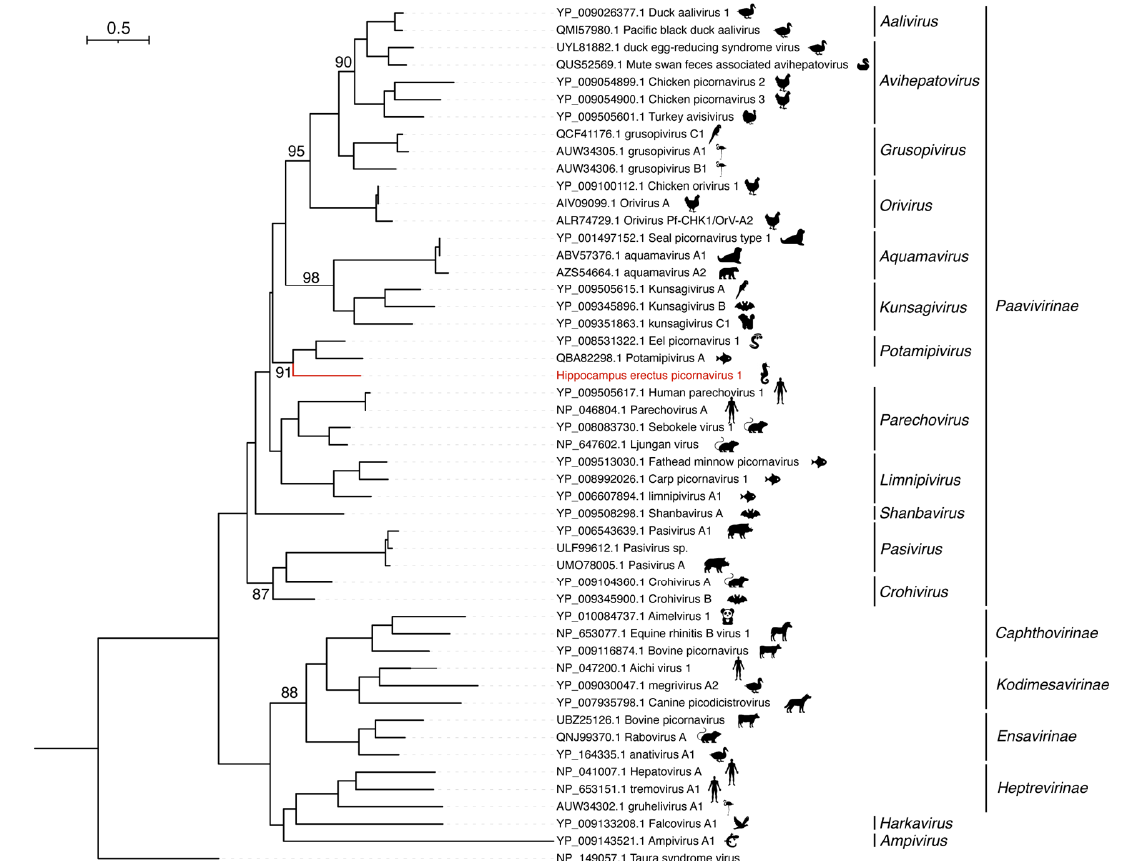
Figure 4. Phylogenetic analysis of the RNA-dependent RNA polymerase (RdRp) sequences of Hippocampus erectus picornavirus 1 (HePcV1). Phylogenetic analysis was performed using IQ- TREE, with the best-fit model LG + I + G4 and 1000 bootstrap replicates. Only bootstrap values > 80% were shown.